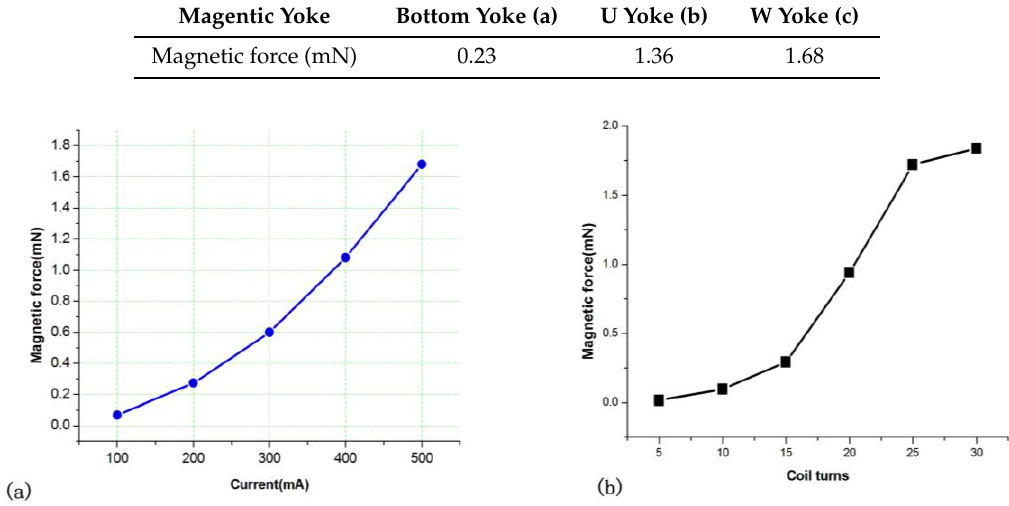
Figure 9. The magnetic force with different driving current and coil number turns. ( a ) magnetic force with current; ( b ) Magnetic force with coil turns.